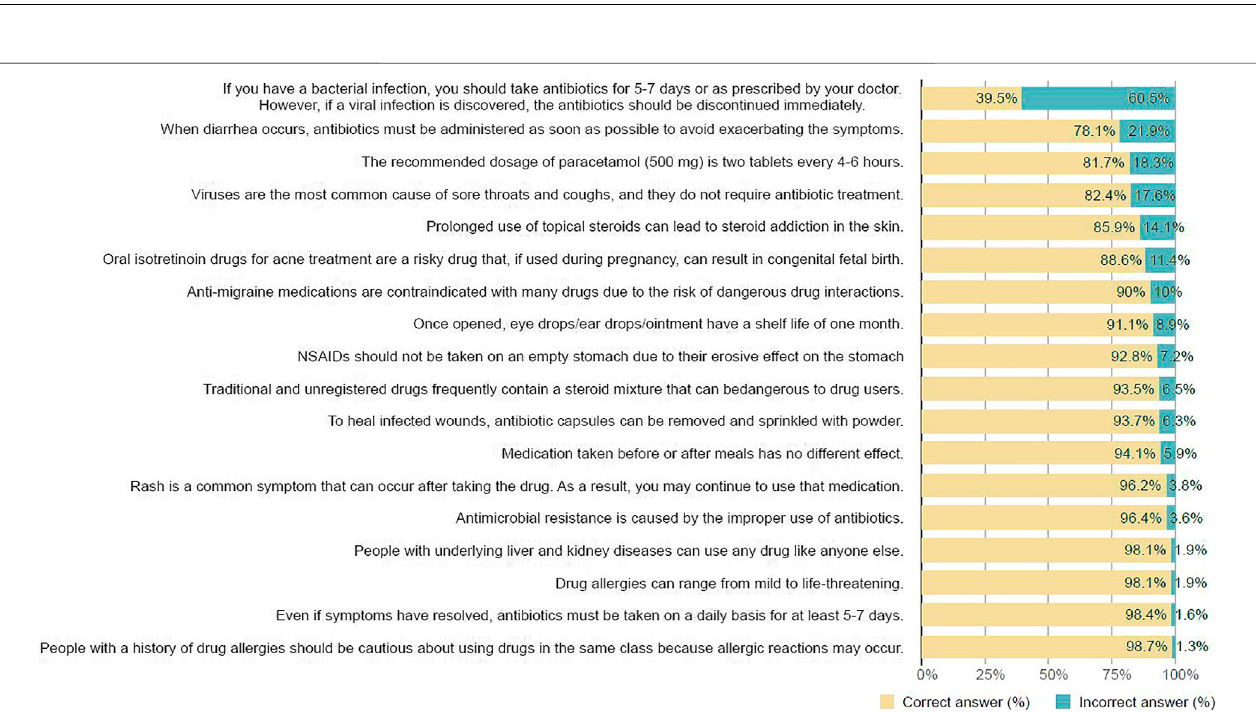
Frontiers in Pharmacology |